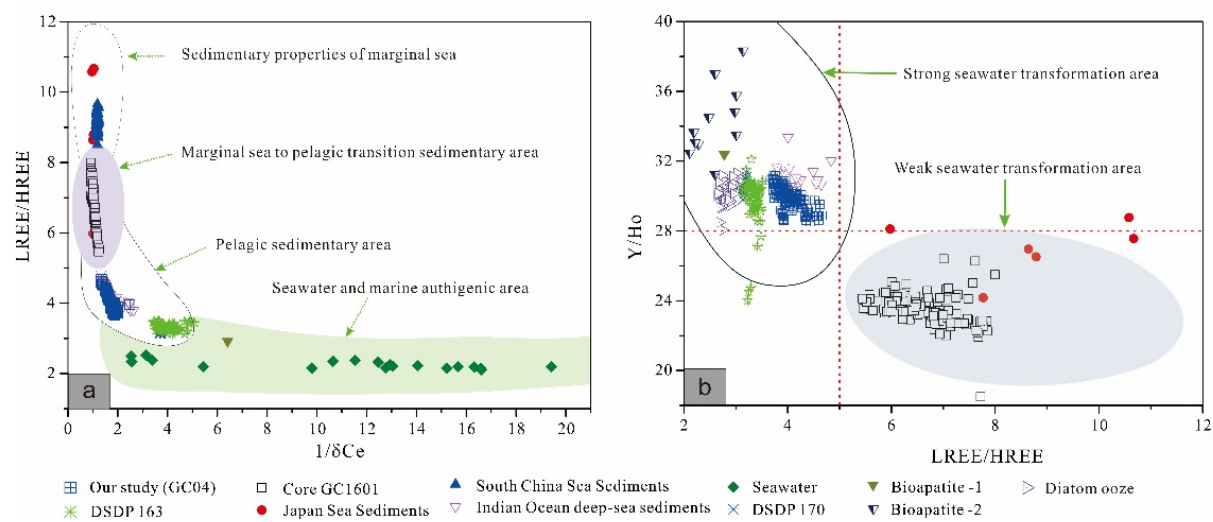
Figure 10. ( a ) LREE/HREE vs. 1/ δ Ce and ( b ) LREE/HREE vs. Y/Ho diagrams. The data are taken from: bioapatite-1 [67]; bioapatite-2 [68]; DSDP 163 [66]; Indian Ocean deep-sea sediments values [69]; Diatom ooze values [36]; Core CC1601 [37]. Other data sources are the same as in Figure 8.